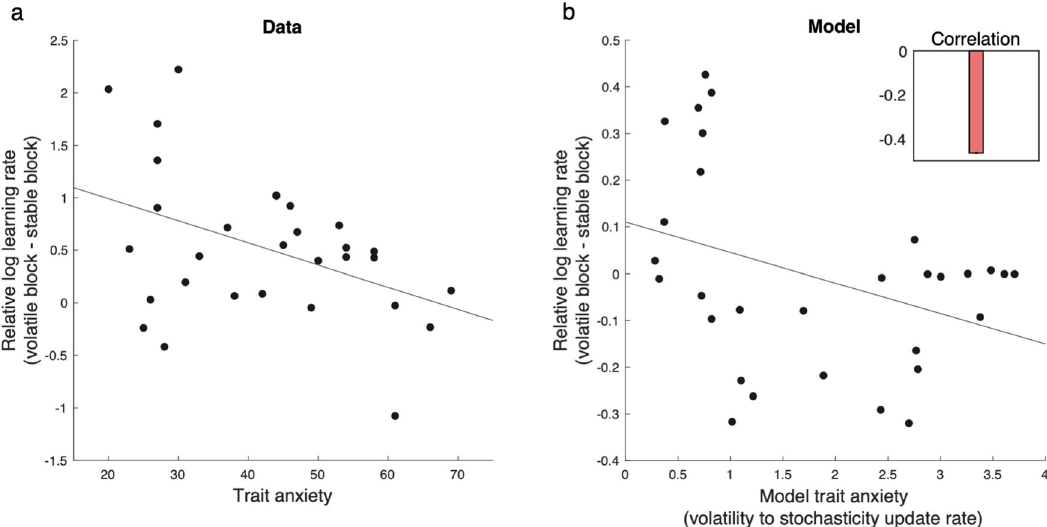
Fig. 6 The model explains effects of trait anxiety as a continuous index on learning. a Data by Browning et al. 13 show a signi fi cant negative correlation between relative log learning rate and trait anxiety in a probabilistic switching task with stable and volatile blocks. b The model shows a similar pattern. The inset shows the median rank correlation between the trait anxiety and the relative learning rate. Model trait anxiety is de fi ned as the ratio of volatility to stochasticity update rates (thus higher if the stochasticity update rate is small). The lesion model of anxiety (Fig. 5) is a special case in which the stochasticity update rate is zero. Errorbars re fl ect standard error of the median over 1000 simulations and are too small to be visible. Source data are provided as Source Data fi